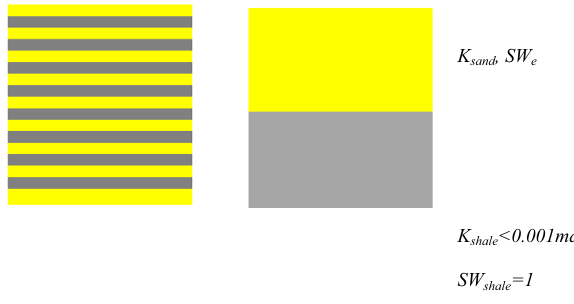
Fig. 6 Conceptual model for laminated sand modelling (grey colour representing shale and yellow colour representing